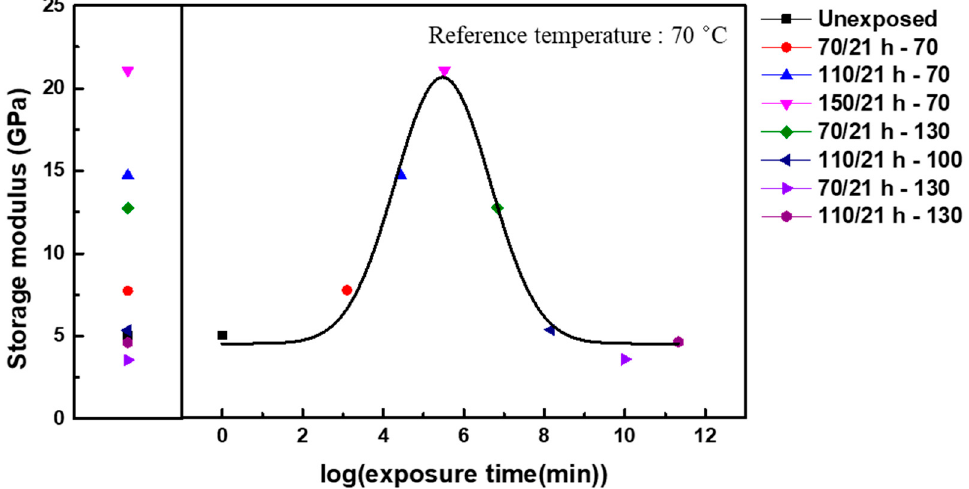
Figure 5. Long-term variation in the storage modulus of CF-SMPCs when maintained at 70 ◦ C under AO irradiation. Legends for each data point represent the AO exposure conditions. The original data were subjected to shift operations.